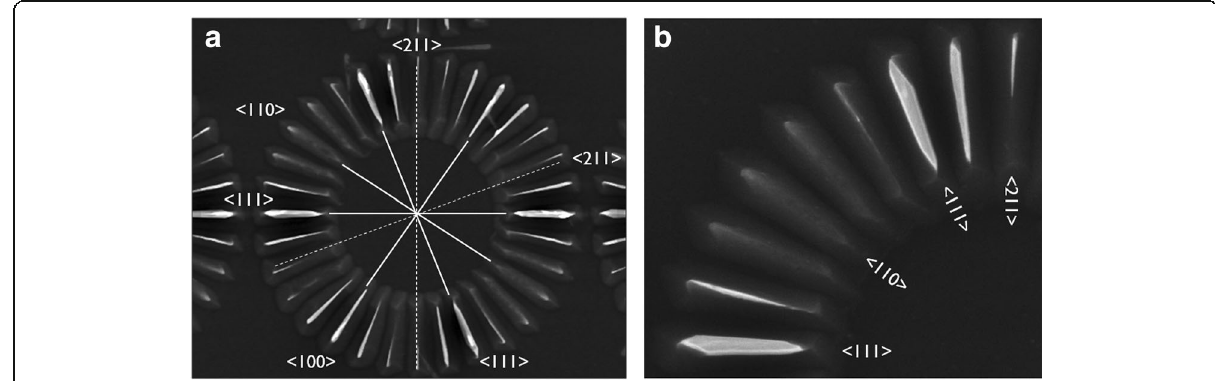
Fig. 4 a TD-SEM of a Si(110) wagon-wheel etched in low-concentration TMAH (5 wt.%) at RT and zoom-in ( b ) showing the facet formation on the <111> oriented spokes. The main crystallographic directions (or equivalent planes) are represented by solid lines, the higher index planes by dashed